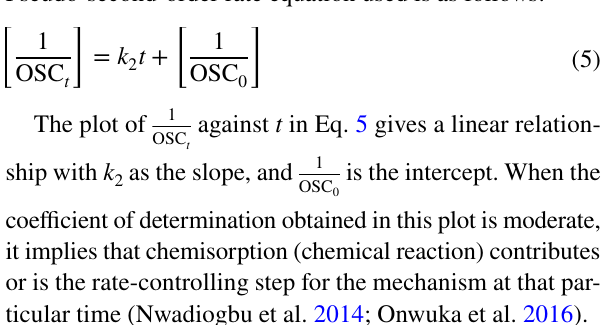
Table 2 Kinetic data for crude oil sorption by the sorbents boldedSample Modified